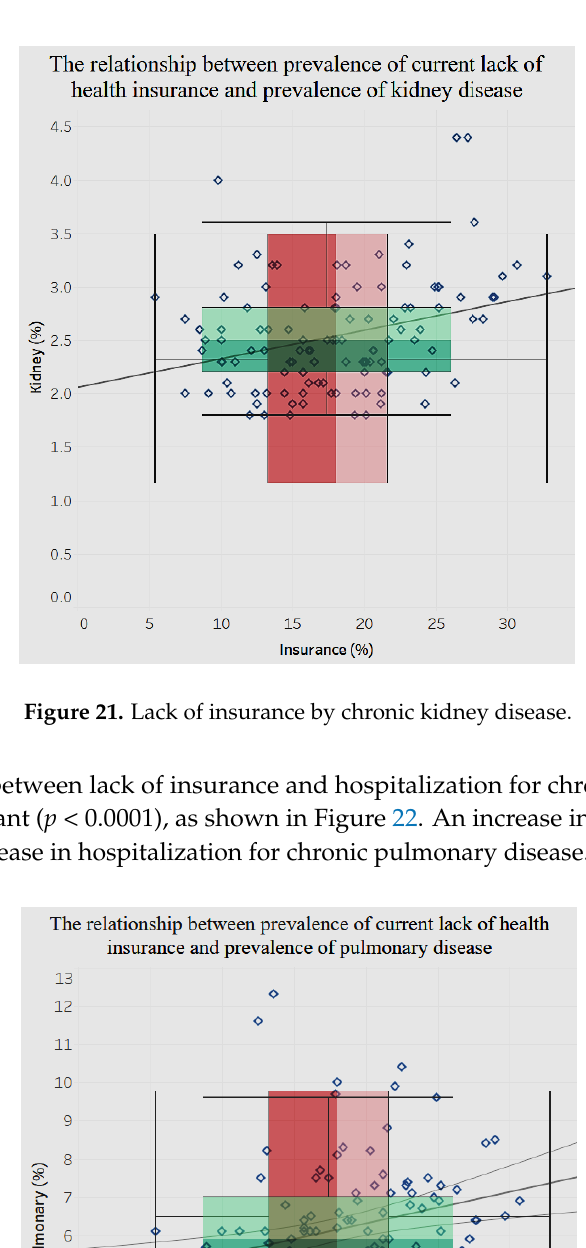
Figure 20. Current lack of health insurance by diagnosed diabetes.